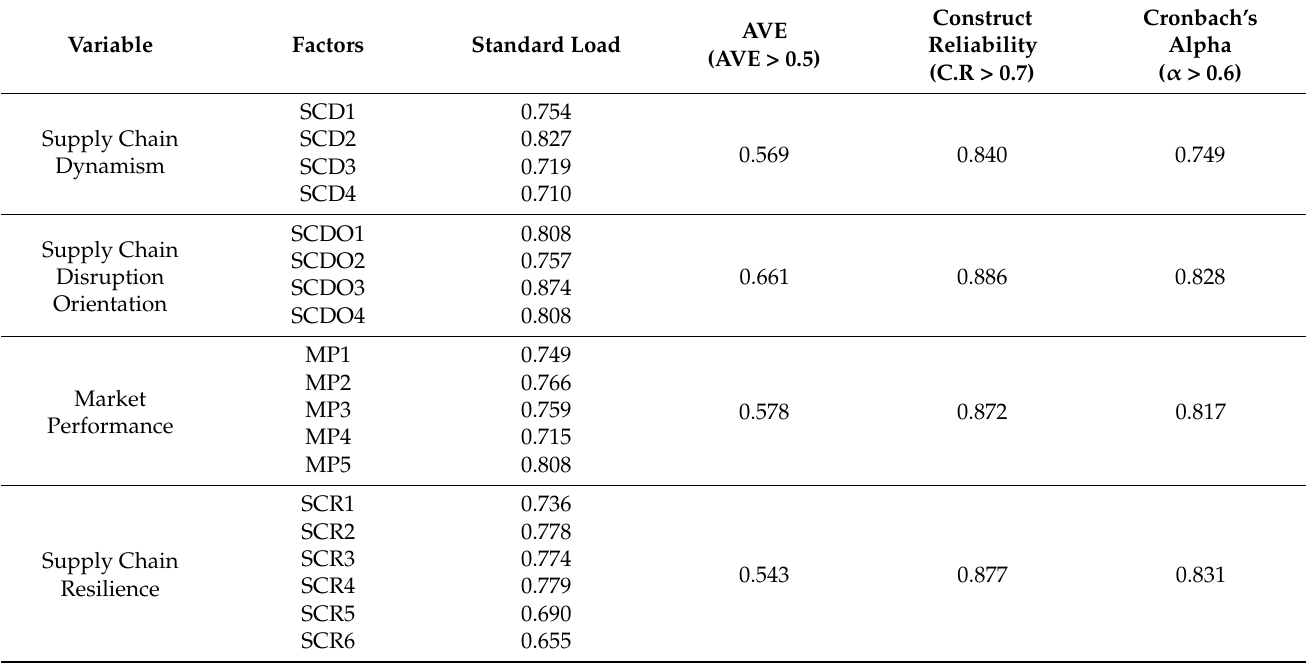
Table 3. Outer Model Assessment.